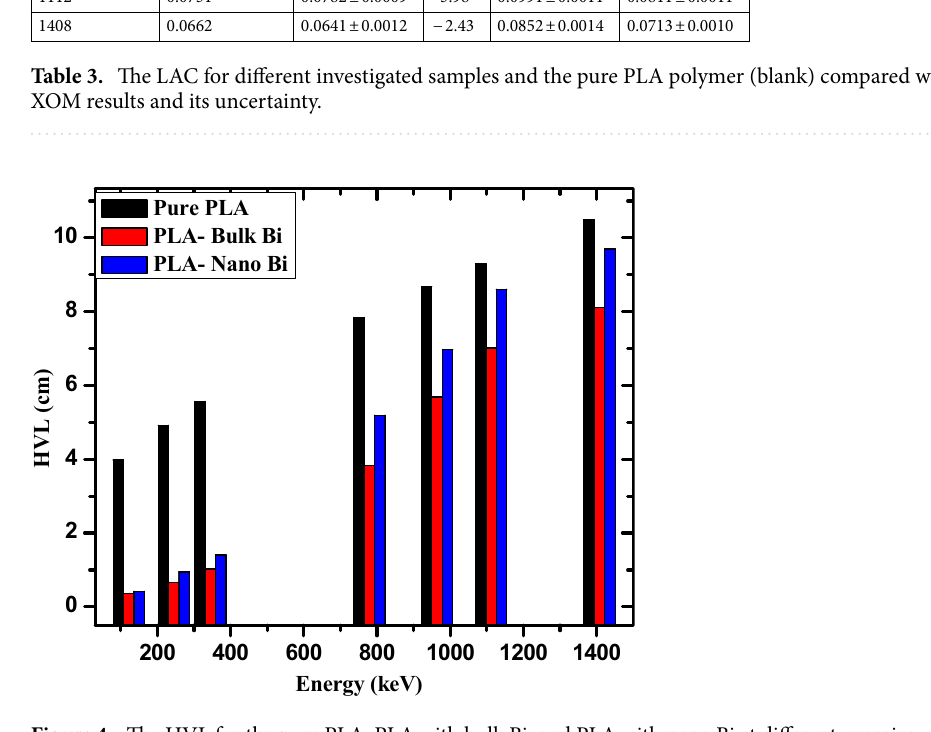
Figure 4. The HVL for the pure PLA, PLA with bulk Bi, and PLA with nano Bi at different